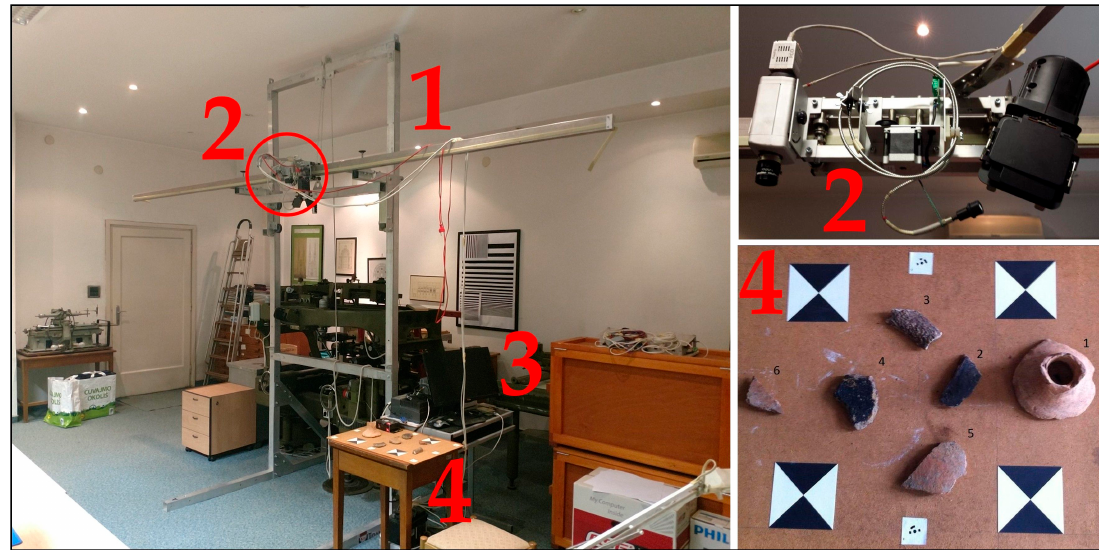
Figure 4. ( 1 ) Sensor bracket; ( 2 ) HSLS V9, diffuse collector, halogen lamp, engine (in red circle), ( 3 ) Control system (industrial controller and motor controller) and ( 4 ) Table with Roman archaeological artefacts found in Sisak, Croatia [55].